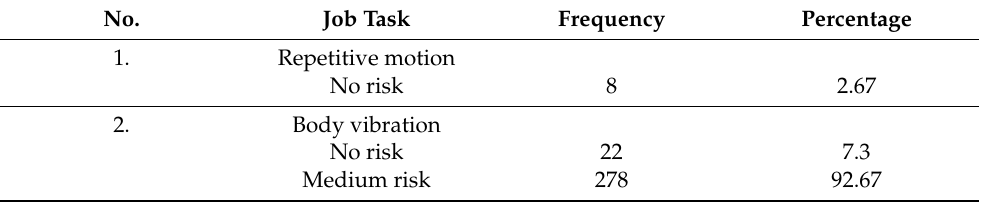
Table 3. List of job tasks undertaken by nurses at the hospital with their WRMSD symptom frequencies.